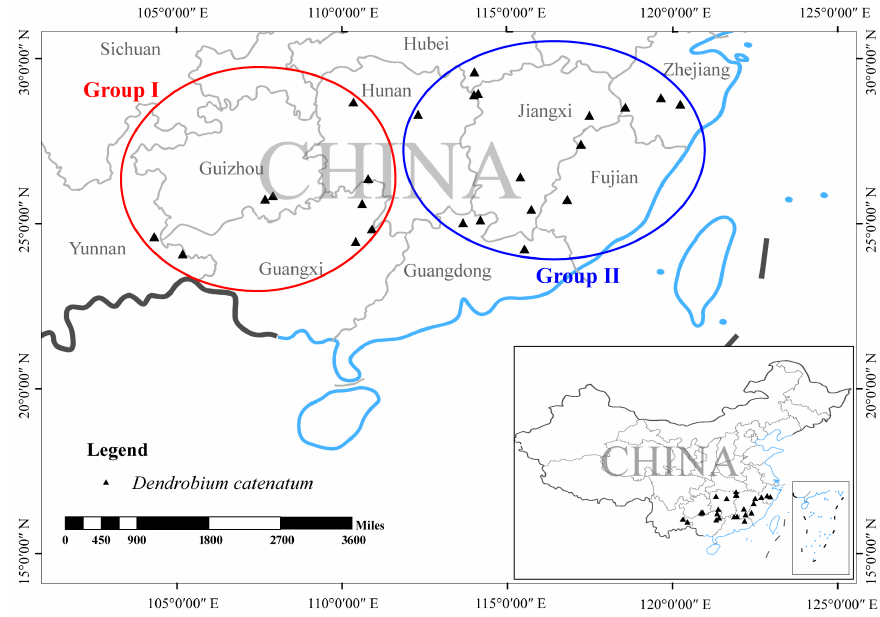
Figure 1. Sampling locations of D. catenatum species used in this study.